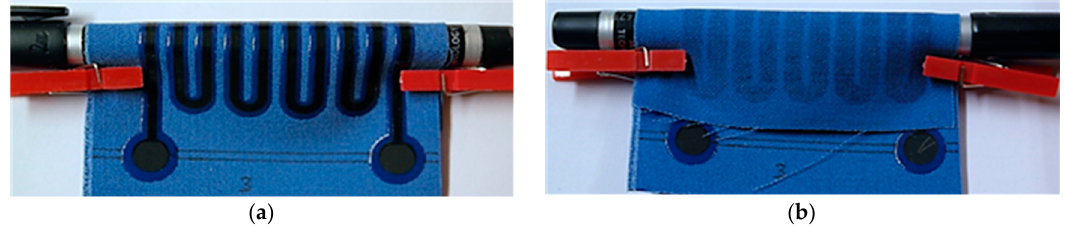
Figure 2. Printed Bari fabric in negative bending ( a ) and positive bending ( b )